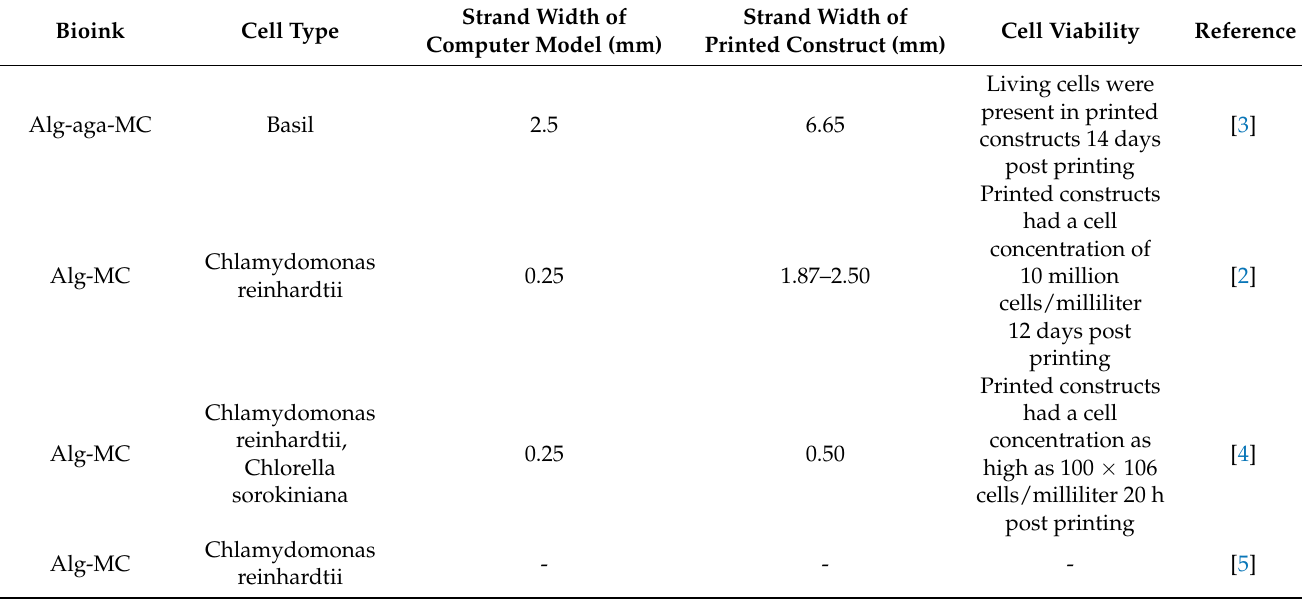
Table 1. Summary of reported studies on green